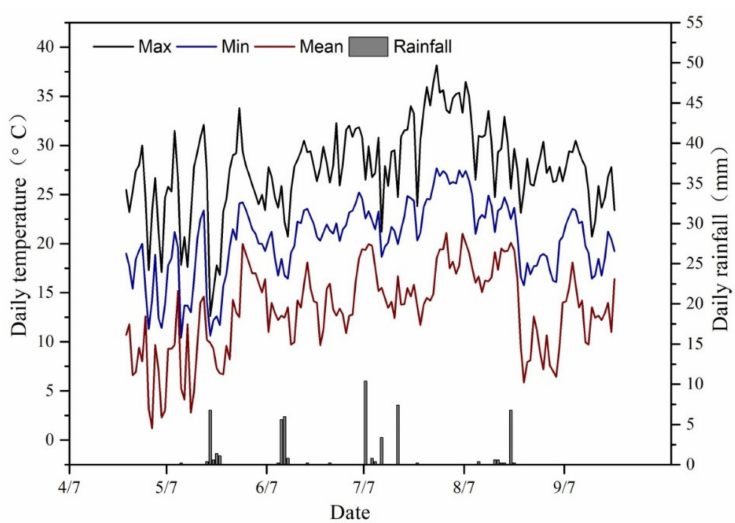
Figure A1. Average minimum and maximum temperature and rainfall during the crop growing period during 2016 that the experiment was carried in Fenzidi experimental site where it was arid and semi-arid climate.